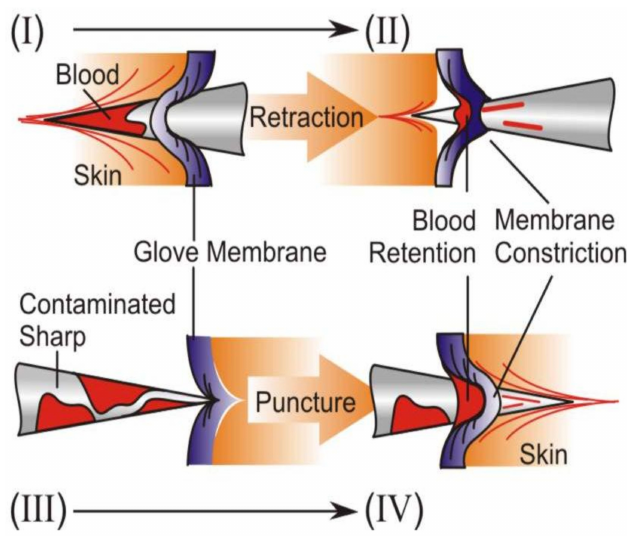
Figure 7. Influence of glove on the removal of biofluids upon initial penetration of a clean MN (I → II) and upon accidental puncture by a previously contaminated patch (III →